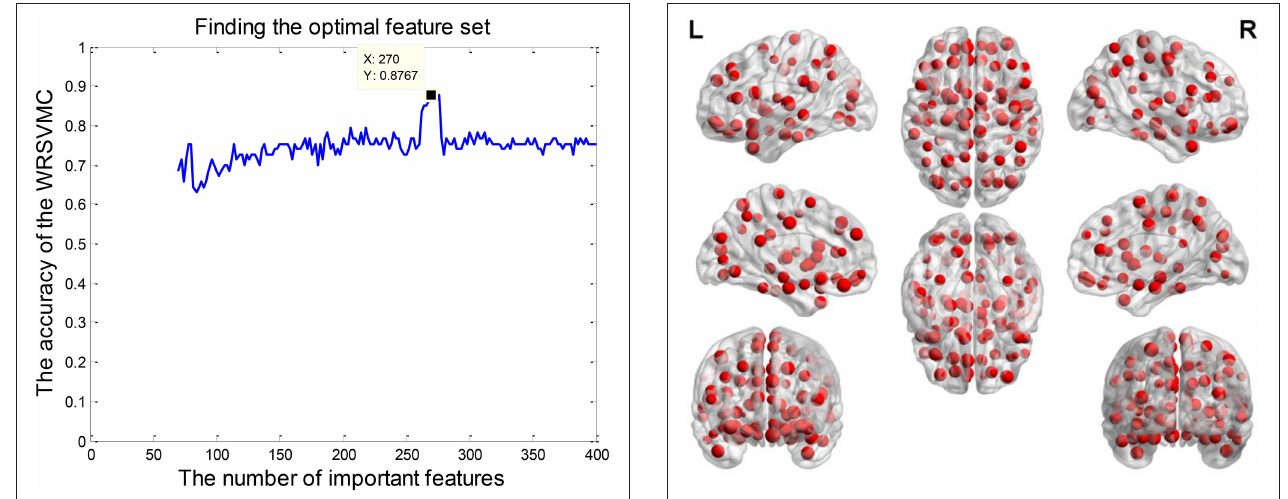
FIGURE 6 | The number of optimal features.